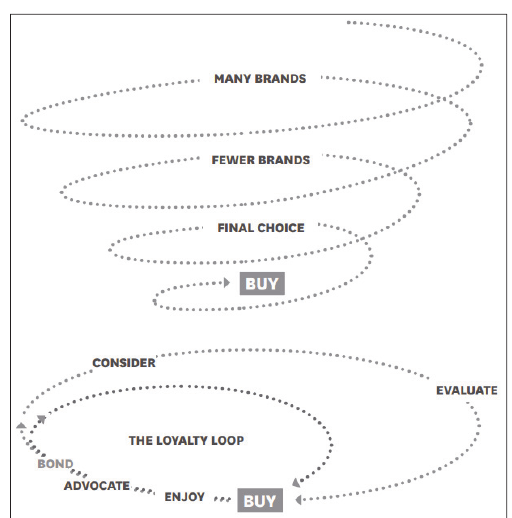
<Figure 1> Funnel model and CDJ model of customer decision making process (David